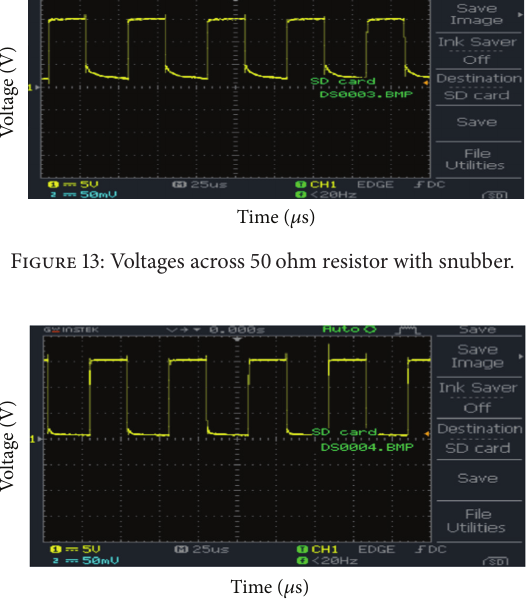
Figure 14: Voltage across 50 ohm resistor without